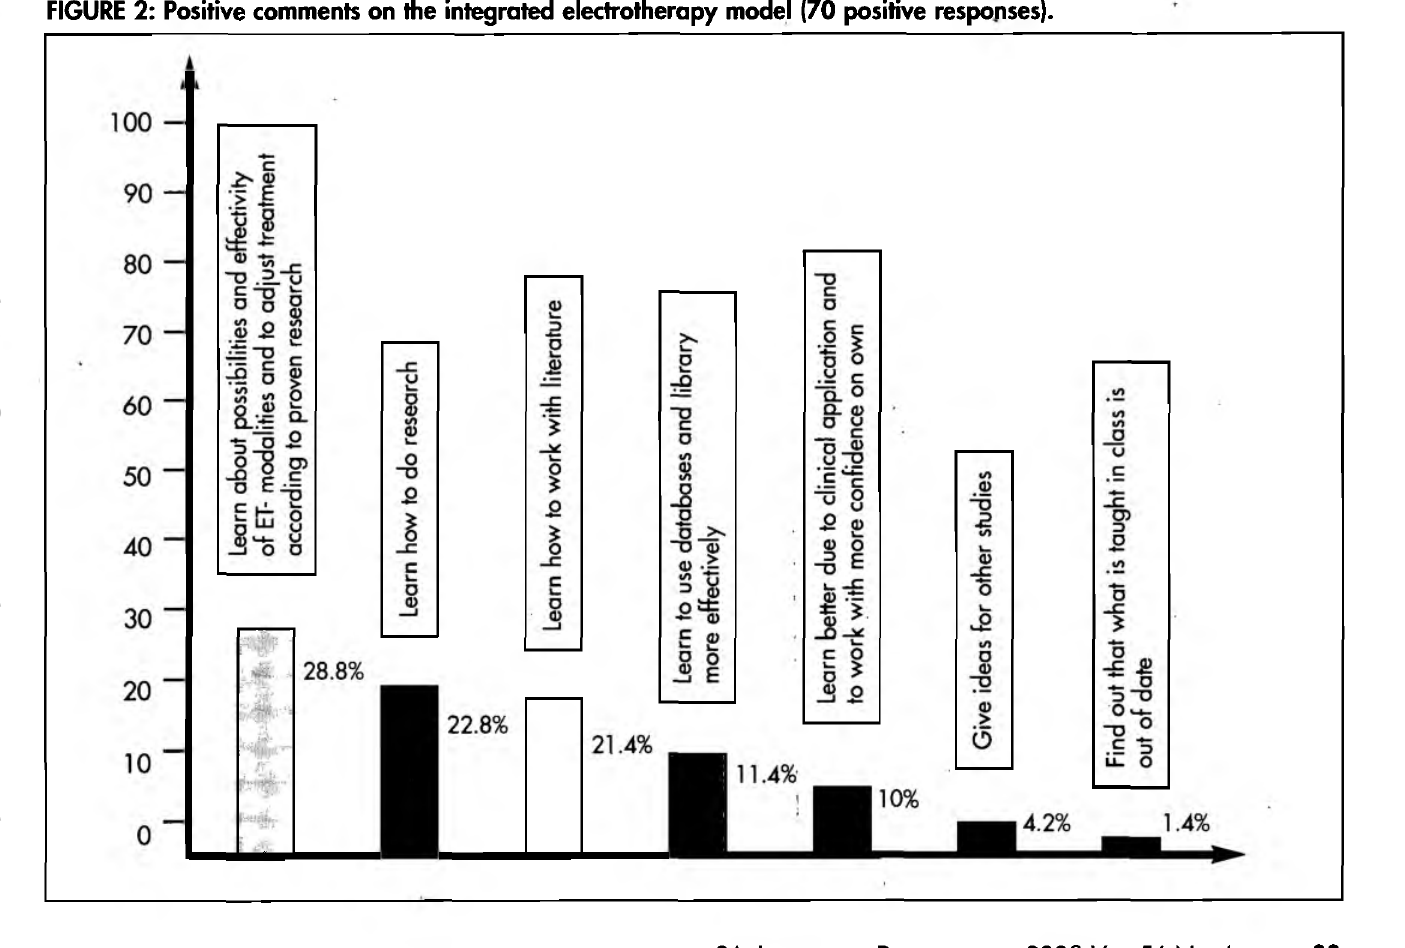
FIGURE 2: Positive comments on the integrated electrotherapy model (70 positive